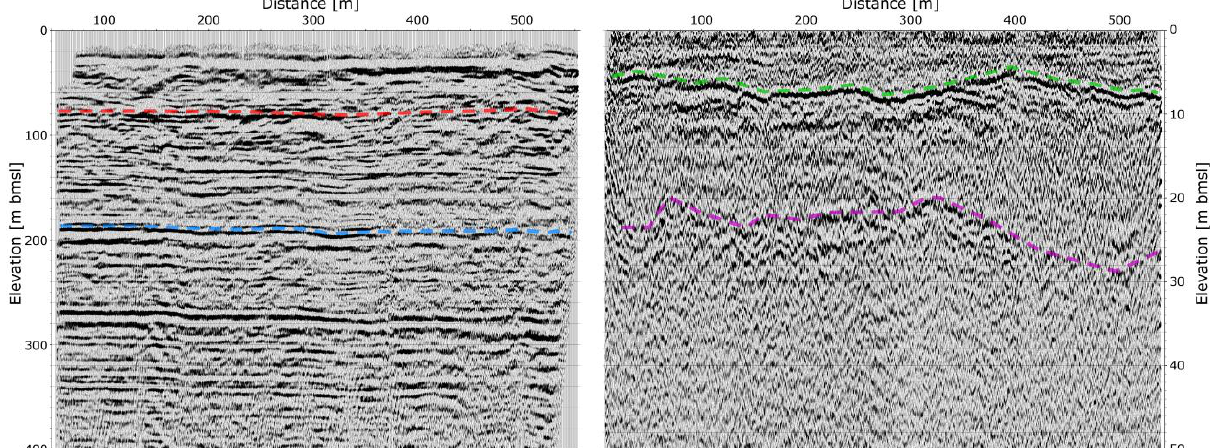
Fig. 8. Seismic results, (left panel) P-wave section, (right panel) S-wave section (note the different depth Figure 8. Seismic results, (left) P-wave section, (right) S-wave section (note the different 2 depth scales). 3